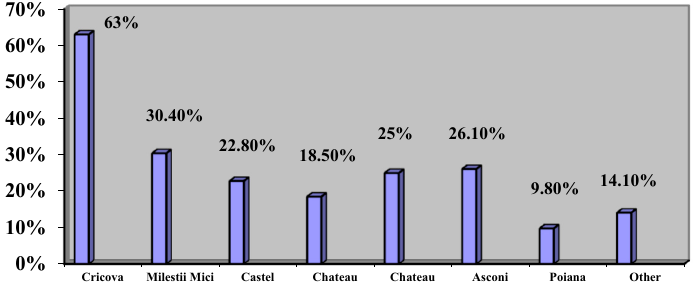
Figure 6. The number of visits of the respondents to the most popular wineries in the Republic of Moldova.